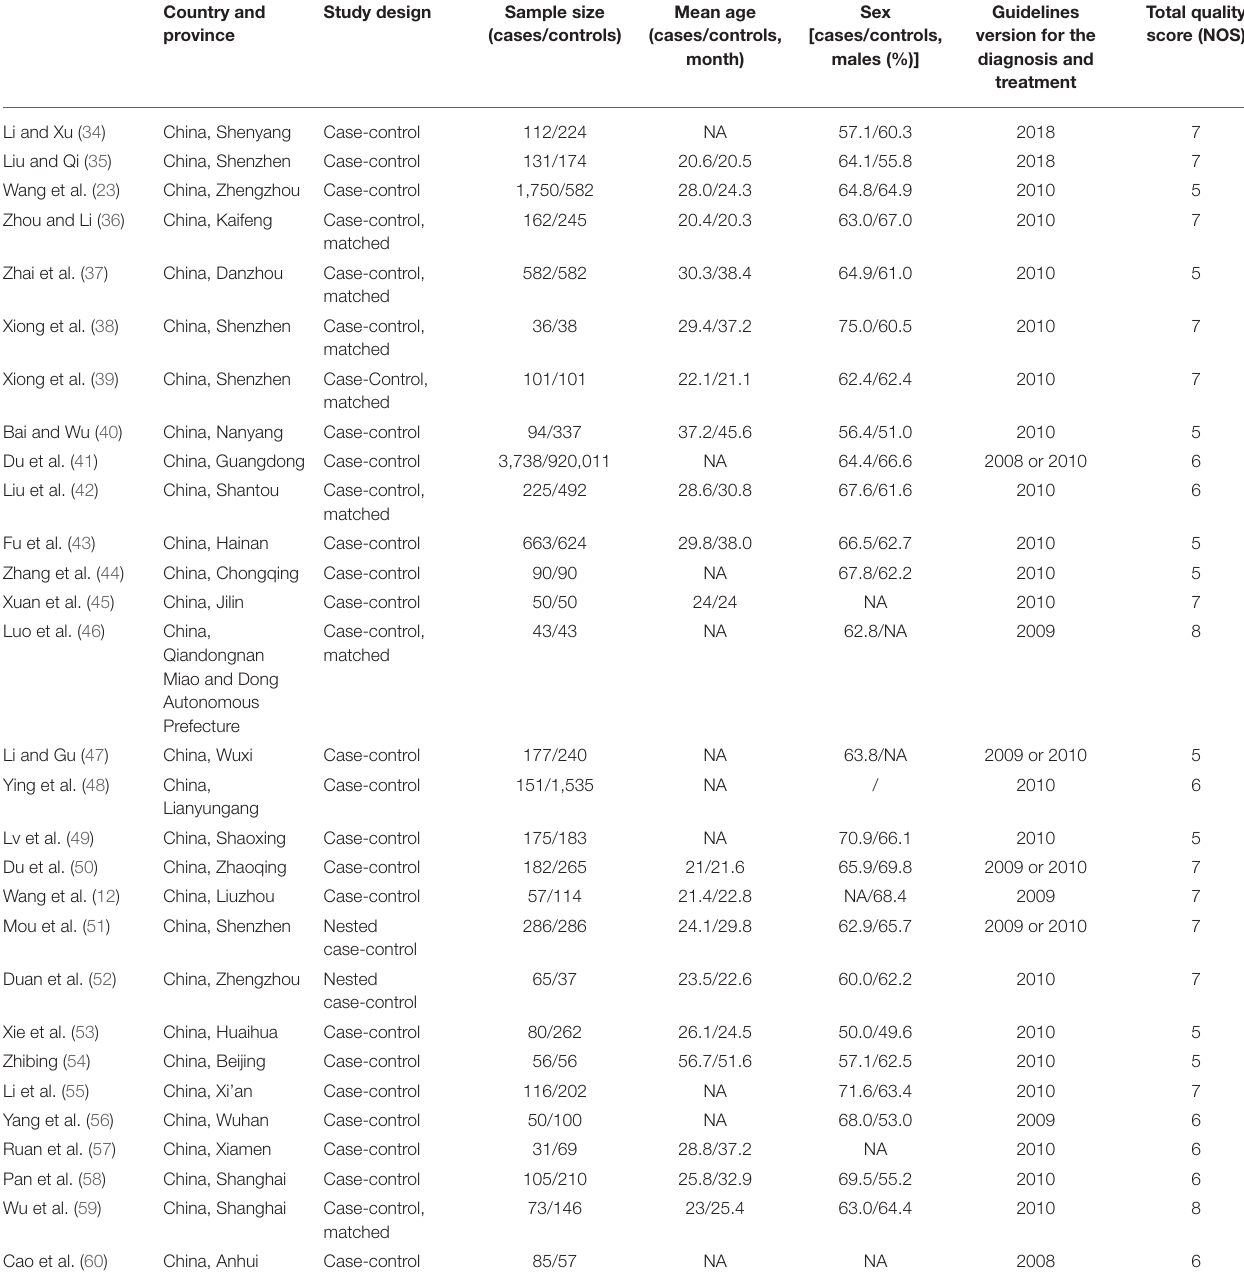
TABLE 1 | Characteristics of the included studies. Country and Study province